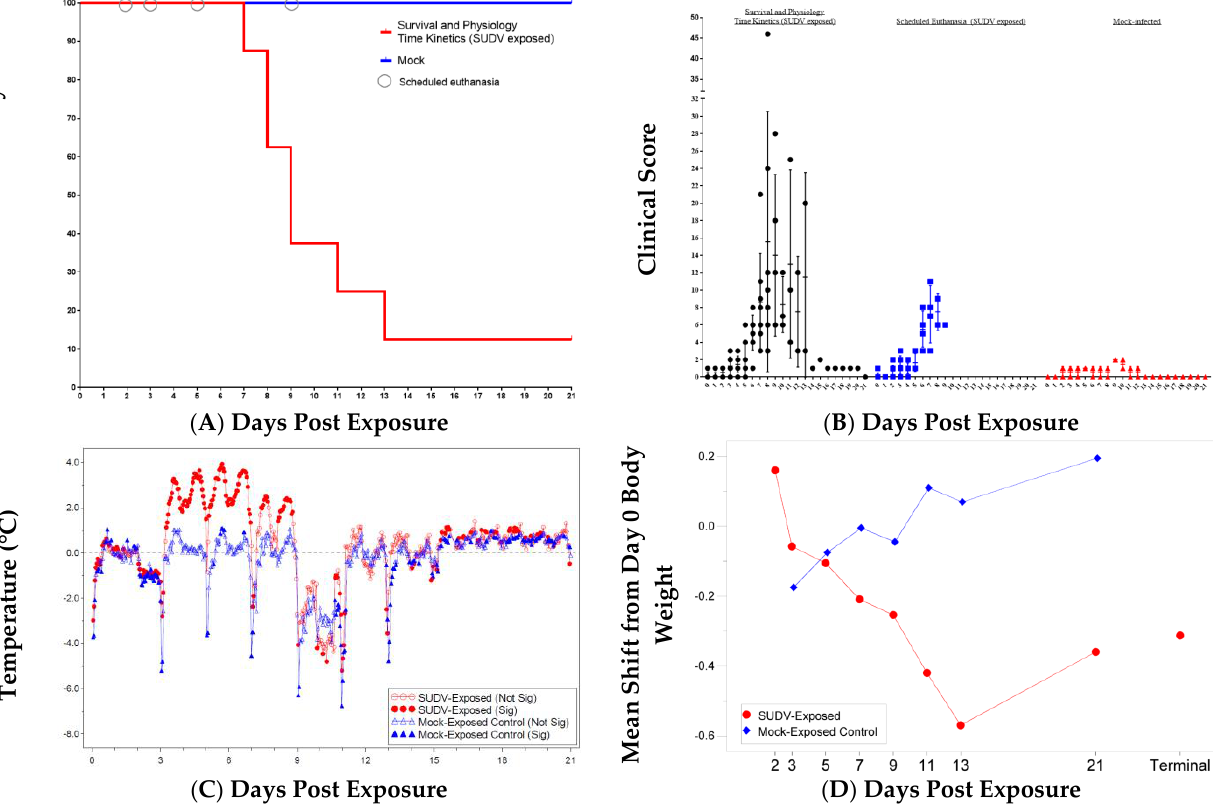
Figure 1. Disease Progression in Cynomolgus Macaques Exposed to SUDV. Group comparisons are displayed for ( A ) Survival probability. ( B ) Daily clinical scores (highest score per day); group comparison with individual values, mean, and standard deviation displayed. ( C ) Body temperature changes (°C), mean shift from Day 0, telemetry; Least Square Means Plot. ( D ) Body weight change (kg), mean shift from Day 0; T represents Terminal (data collected from animals that met euthanasia criteria were combined and reported as a single terminal time point).